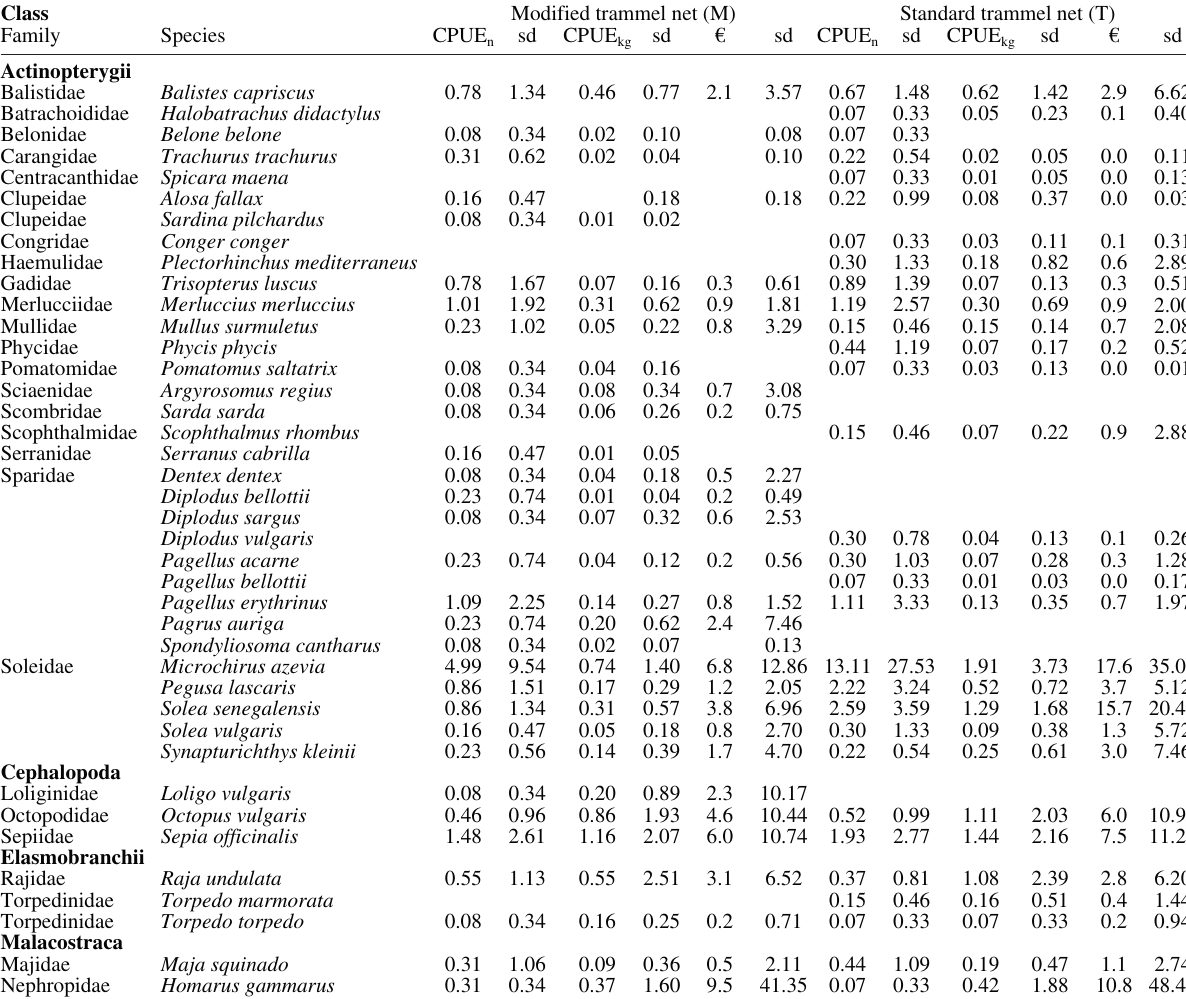
deviations (sd) of landed species for modified trammel net (M) and standard trammel net (T).